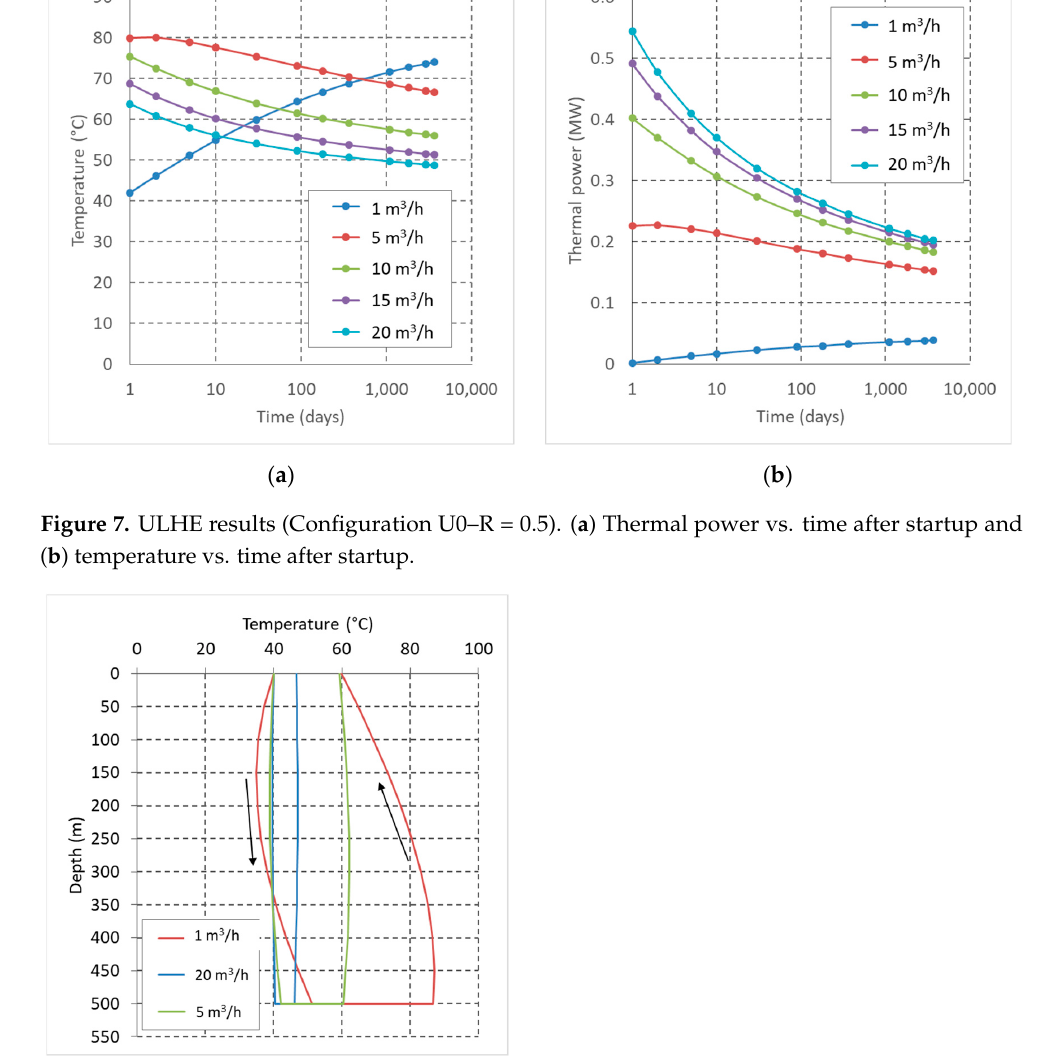
Figure 8. Temperature profiles for different flow rates in the ULHE configuration after one year from startup (Configuration U0–R = 0.5).